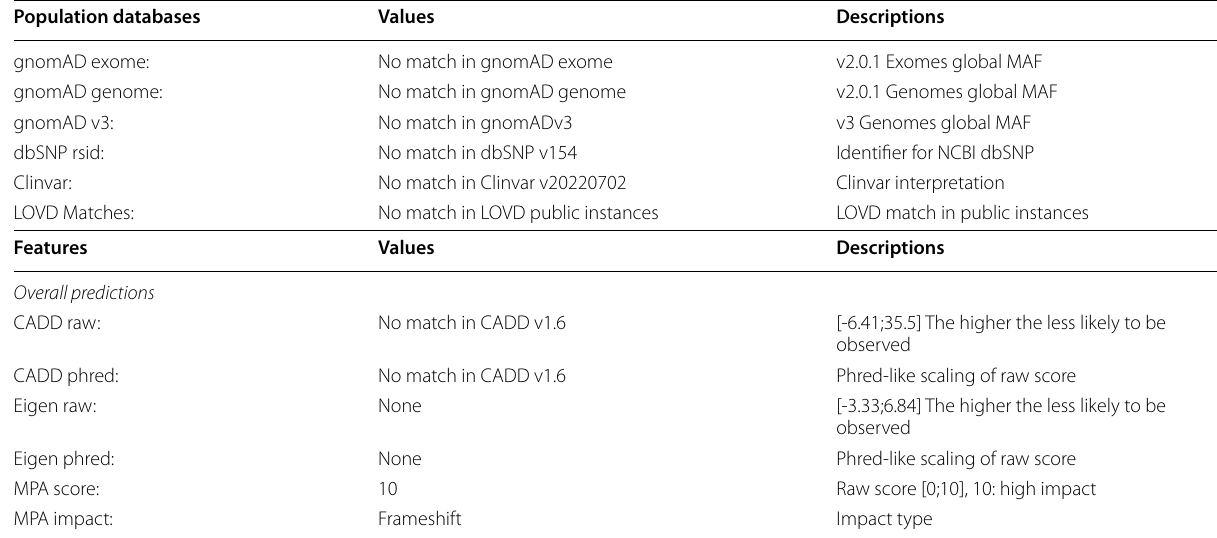
Table 3 Population frequencies and predictions for the novel variant c.597delG (p.Glu199AspfsTer3) Population